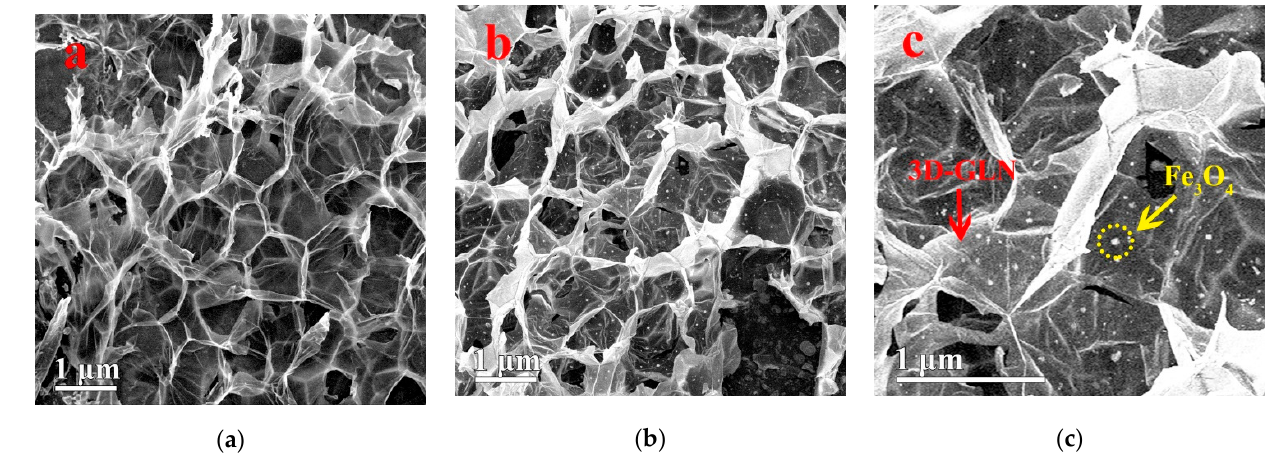
Figure 2. The SEM images of 3D-GLN ( a ) and 3D-GLN/Fe 3 O 4 ( b , c ). The morphologies and microstructures of the 3D-GLN and the 3D-GLN/Fe 3 O 4